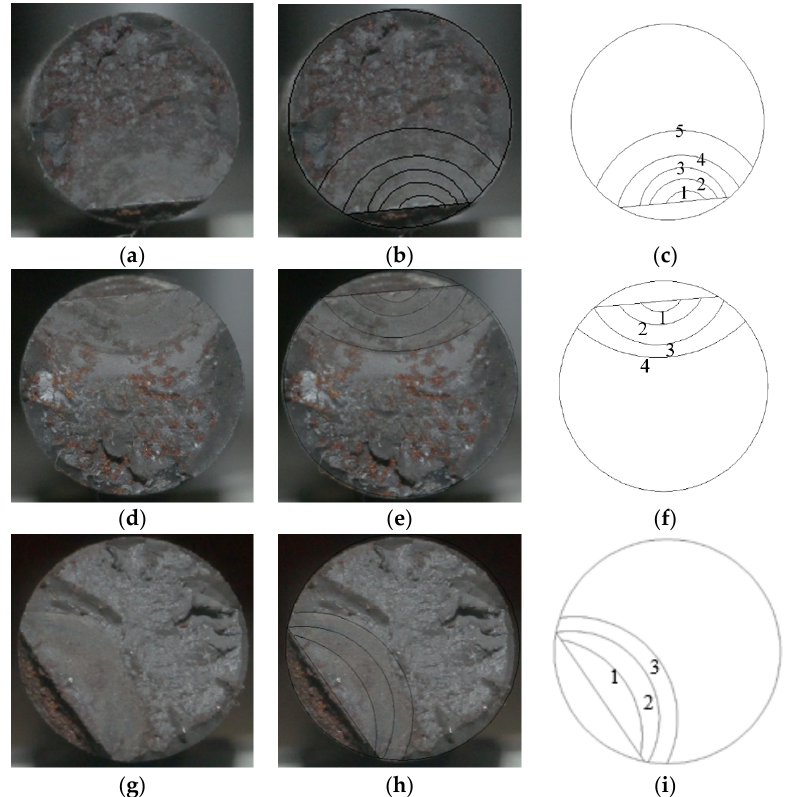
Figure 25. Steel wire sections with notches at different shapes. ( a ) S-1 without “bench-like pattern”; ( b ) S-1 with “bench-like pattern”; ( c ) schematic diagram of S-1 wire specimen; ( d ) S-2 without “bench-like pattern”; ( e ) S-2 with “bench-like pattern”; ( f ) schematic diagram of S-2 wire specimen; ( g ) S-3 without “bench-like pattern”; ( h ) S-3 with “bench-like pattern”; and ( i ) schematic diagram of S-3 wire